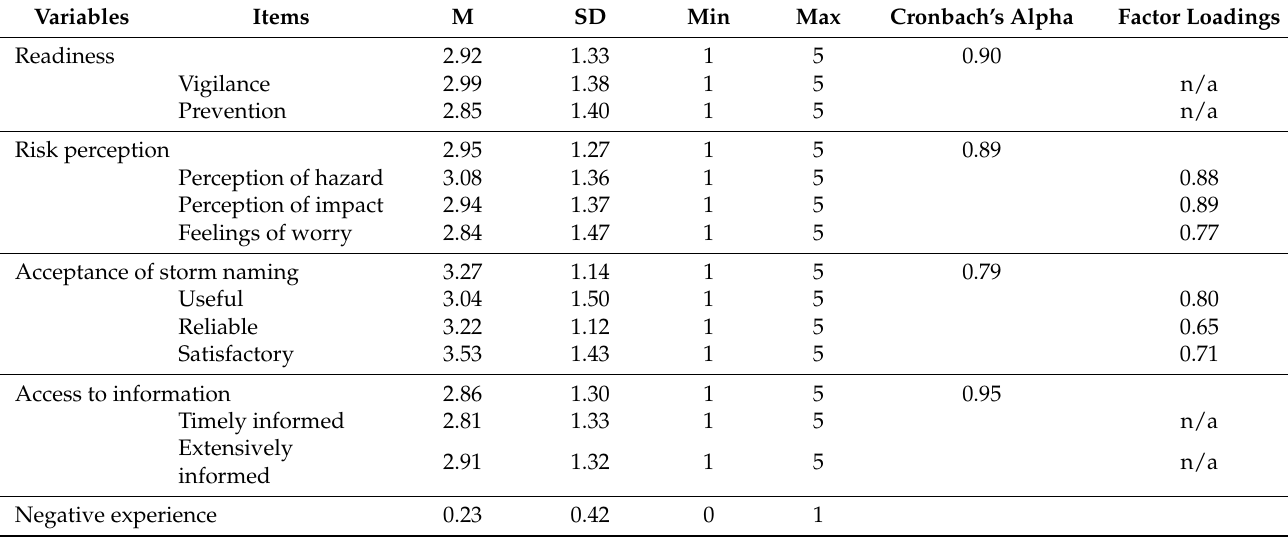
Table 1. Statistics (mean (M), standard deviation (SD), min–max, scale reliability ( α ) and construction (item factor loadings) for readiness and all explanatory variables ( n = 2088, for each